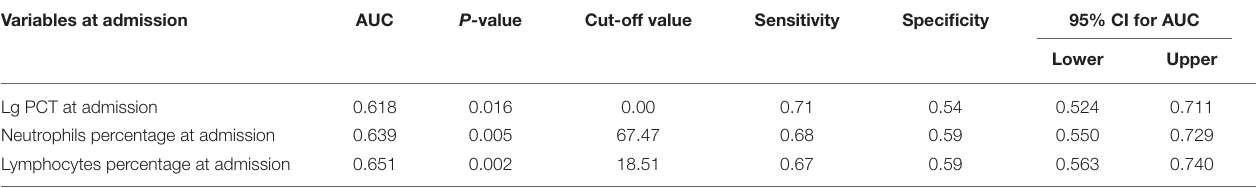
TABLE 5 | Predictive values of parameters for bacterial infection in HFRS patients.